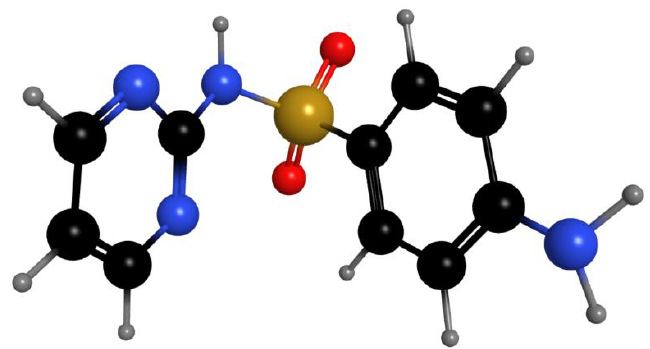
Figure 1. Sulfadiazine (SDZ) structure diagram (black represents C-atom, blue represents N-atom, red represents O-atom, gray represents H-atom, and yellow represents S-atom).